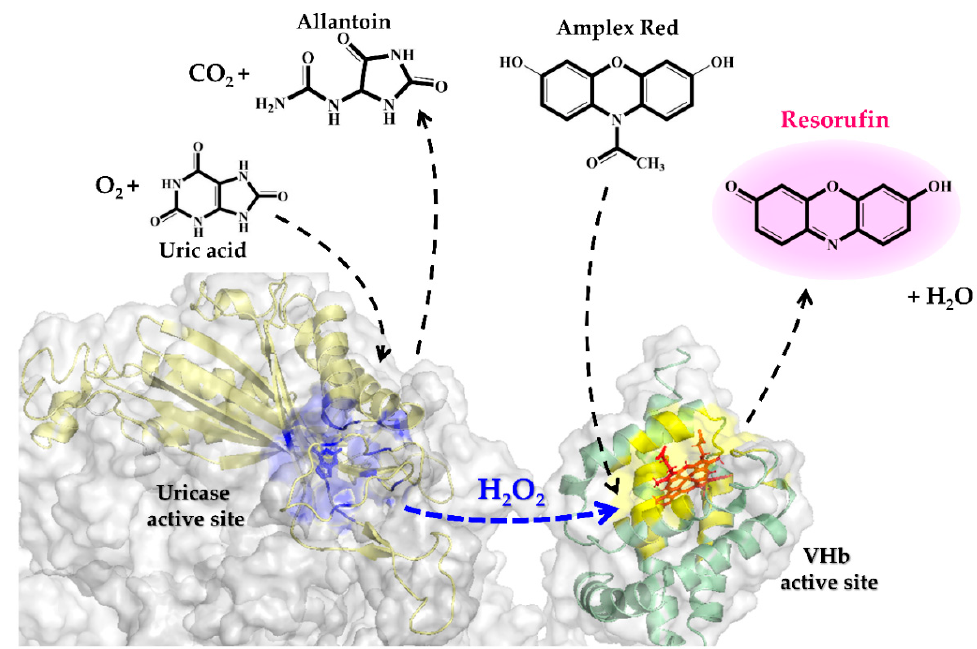
Figure 9. Schematic demonstration of hydrogen peroxide channeling between adjacent CUOX and VHb active sites.